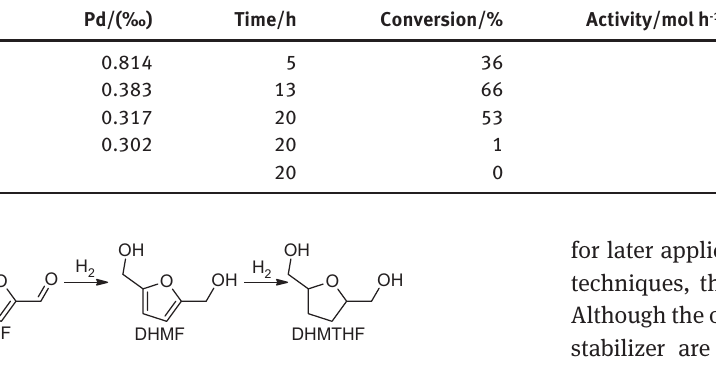
Figure 8 The simplified scheme for the hydrogenation of